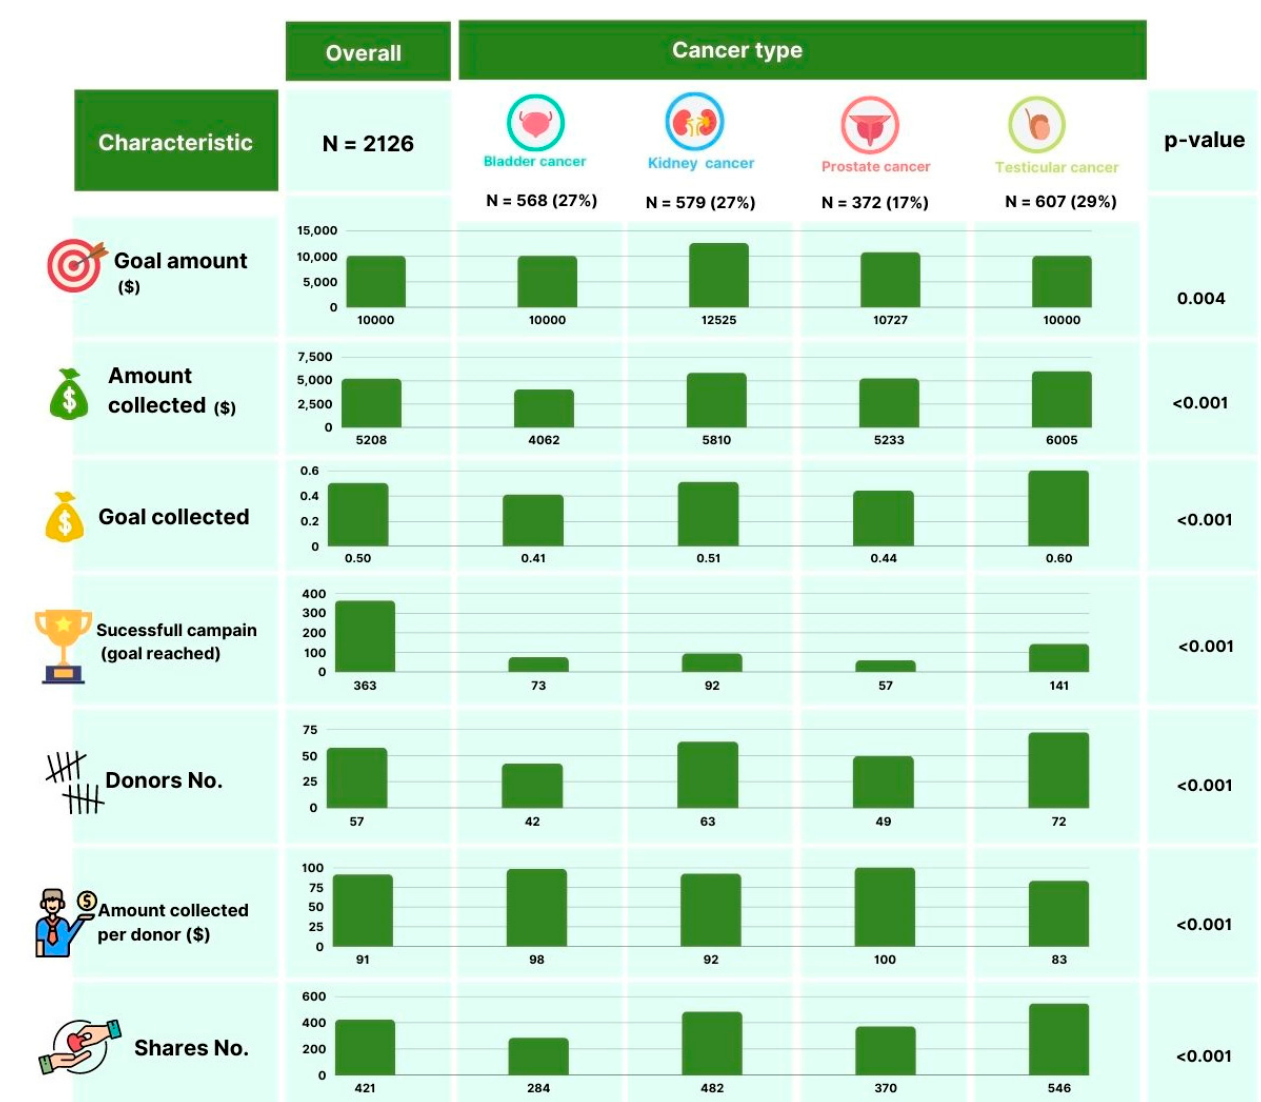
Figure 1. Selected figures of 2126 GoFundMe.com online crowdfunding campaigns fundraising for urologic malignancies stratified by cancer